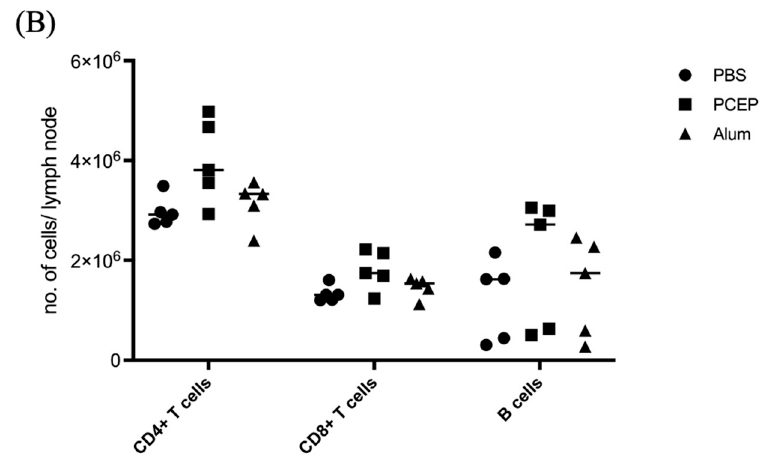
Figure 4. Patterns of Cell Recruitment to the Draining Lymph Nodes in Response to Adjuvants. PCEP stimulates increased immune cell numbers in the draining lymph nodes. BALB/c mice ( n = 5 per group) were injected i.m. with either PBS, PCEP (50 ug) or alum (0.5 mg). The draining inguinal lymph nodes were collected at 24 h post-injection and the cell suspensions were analyzed by flow cytometry. ( A ) Kinetics of myeloid cells (neutrophils, macrophages, monocytes and dendritic cells) 24 h post-injection of adjuvants at the draining lymph nodes. ( B ) Kinetics of lymphoid cells (CD4+, CD8+ and B cells) 24 h post-injection of adjuvants at the draining lymph nodes. Differences in the cell numbers were analyzed by two-way ANOVA and the significant differences between the treatments were compared by Bonferroni multiple-comparison test where **** p < 0.0001. (reprinted with modifications from Awate et al. 2014, Copyright 2014, with permission from Elsevier).